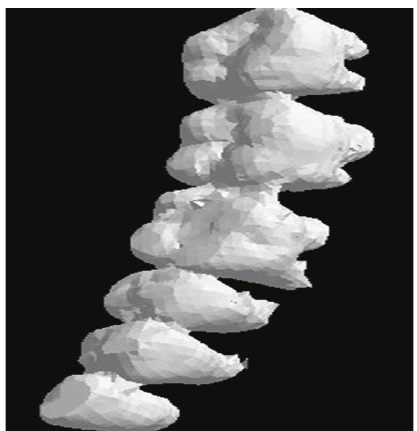
Figure 5: CBCT dental model.